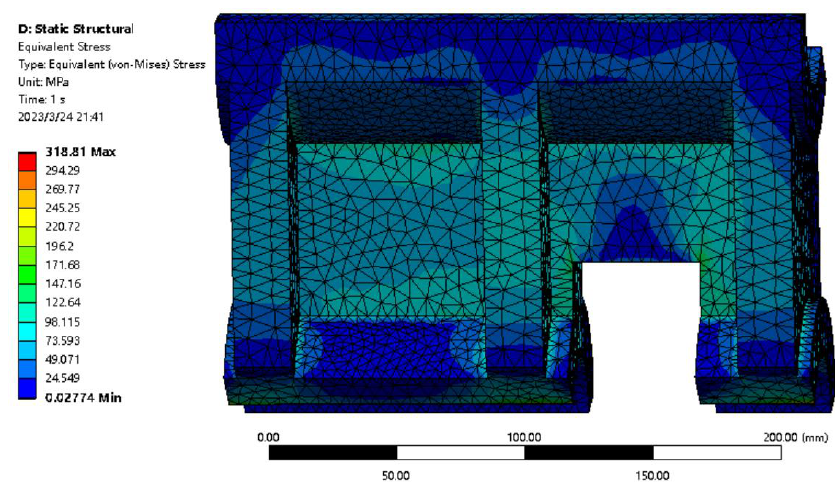
Figure 15. Stress of lightweight drive rod.